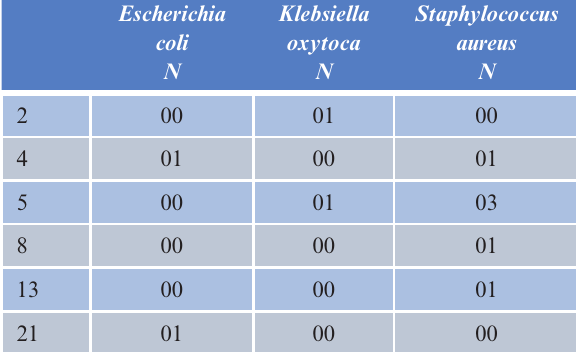
Table 3: Distribution of the length of hospitalization (in days) according to the germs isolated from newborns with urinary tract infection at the Departmental